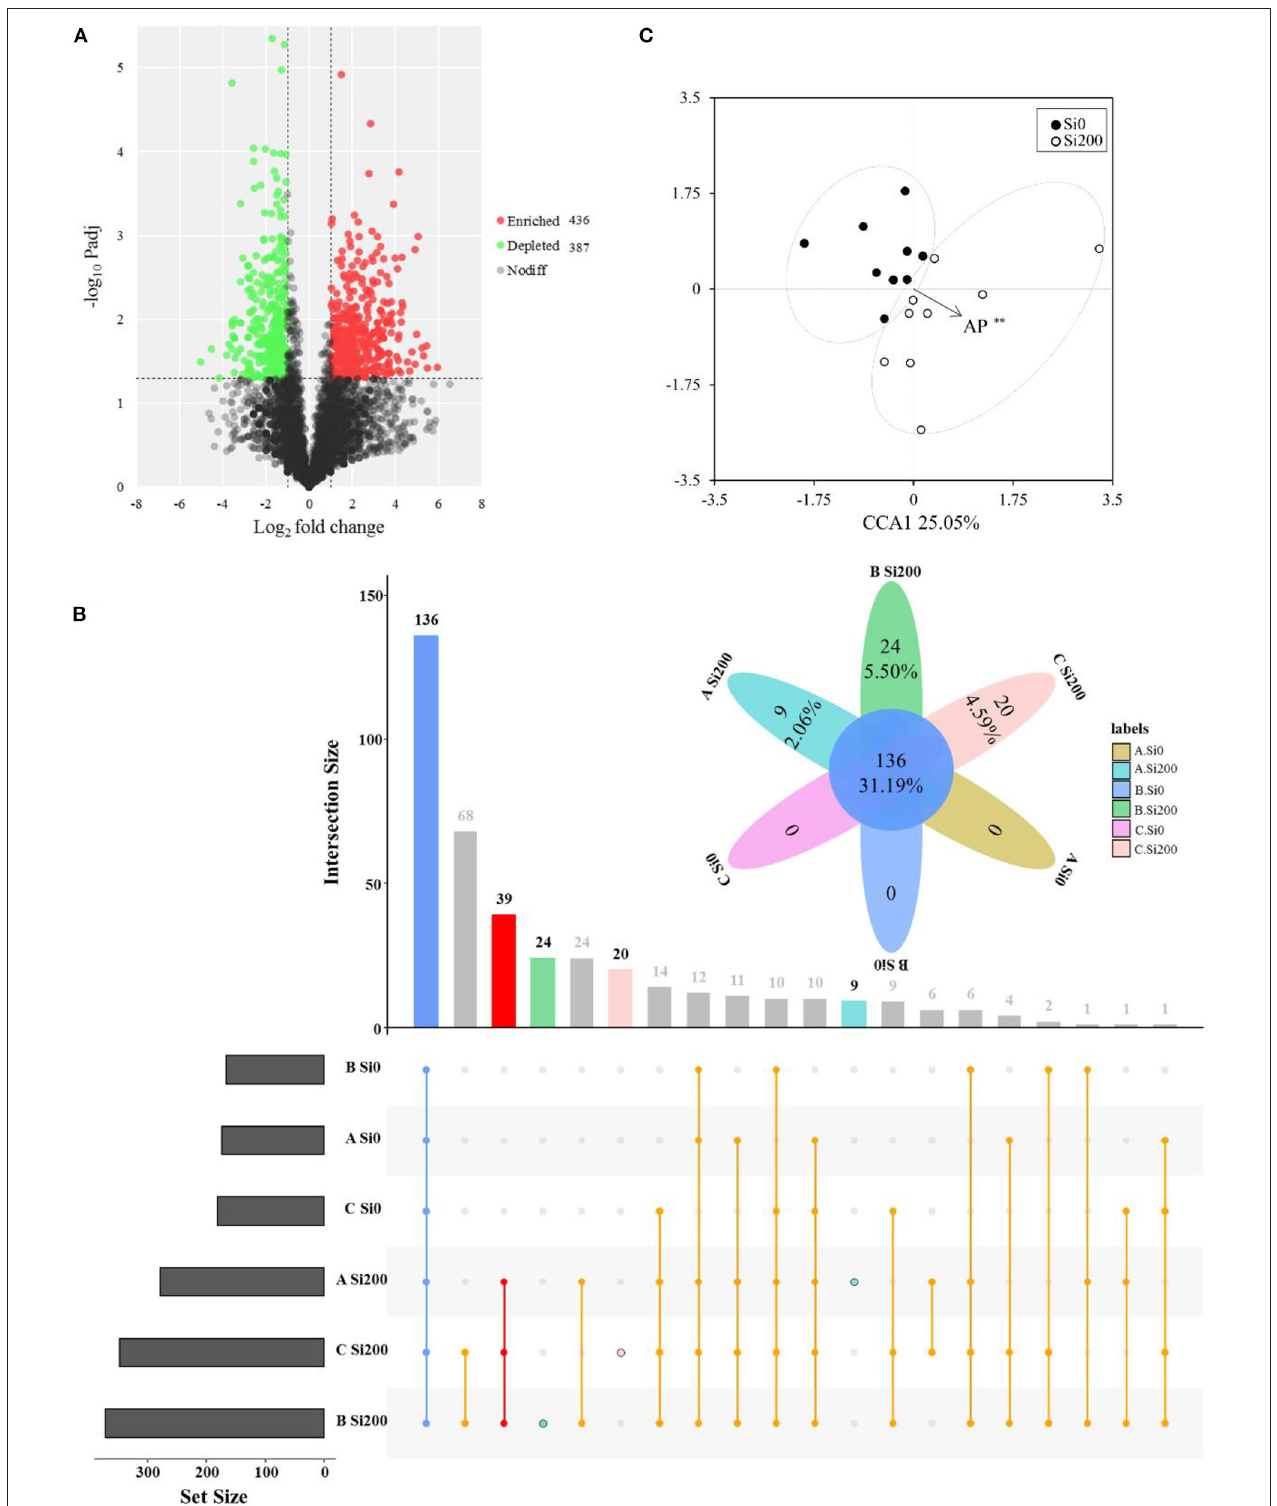
FIGURE 5 | Enrichment and depletion of operational taxonomic units (OTUs) of the three varieties (A) included in the treatment with 200kg of silicon dioxide (SiO 2 ) ha − 1 (Si200) compared with the treatment with 0kg of SiO 2 ha − 1 (Si0) as determined by differential abundance analysis. Each point represents an individual OTU,